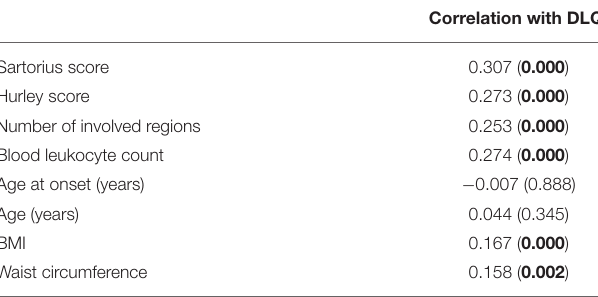
TABLE 3 | Correlations between DLQI and selected clinical data.